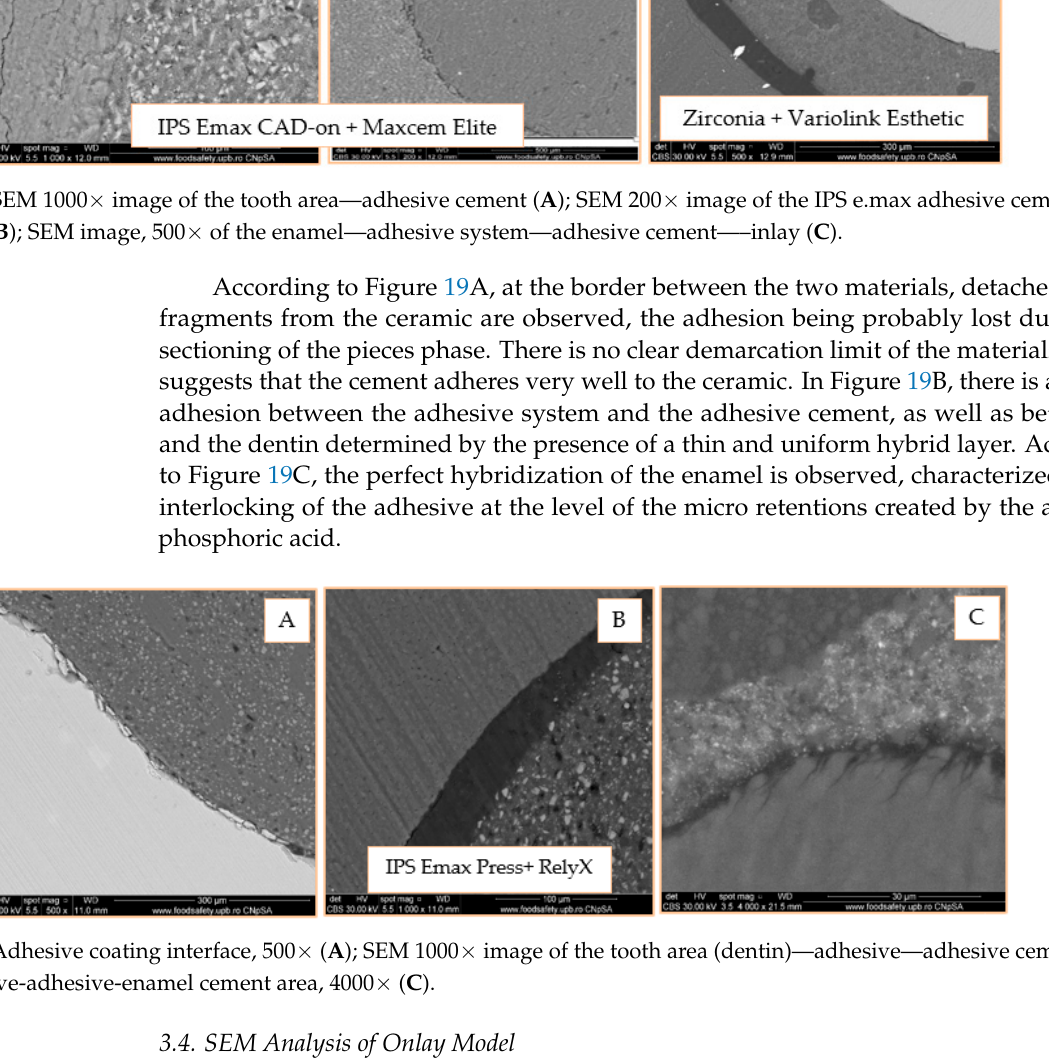
Figure 20. SEM 1000× image of the onlay area—adhesive cement ( A ); SEM 500 x image of the onlay area—adhesive cement ( B ); SEM 500× image of the onlay area—adhesive cement–dentin ( C ). 4. Discussions This study examined the behavior of two restoration models, inlay and onlay, sub- jected to a physiological loading condition of 170 N in value and six directions of orienta- tion. Through the microscopic analysis, the study also examined the way in which the adhesion is made at the level of the restoration/adhesive/tooth interfaces, according to the dental material used. The inlay model simulated a frusto-conical ceramic inlay located in the central area of the molar and inserted into the bone structure to a depth of 4.2 mm. Based on the simulated structure, the equivalent stresses, shear stresses, equivalent strains, and shear strain were extracted from the surface and inside of the model in ac- cordance with the properties of ceramic and adhesive dental materials. The onlay dental reconstruction model was designed to simulate a situation as unfavorable as possible from the mechanical point of view. This was achieved by a dimensional jump at the level of the ceramic element, in the vicinity of which a high concentration of stresses is expected. A very recent study that analyzed the transmission of stresses in ceramic inlays showed that the highest values of stress occurred in teeth restored with inlay, the stresses